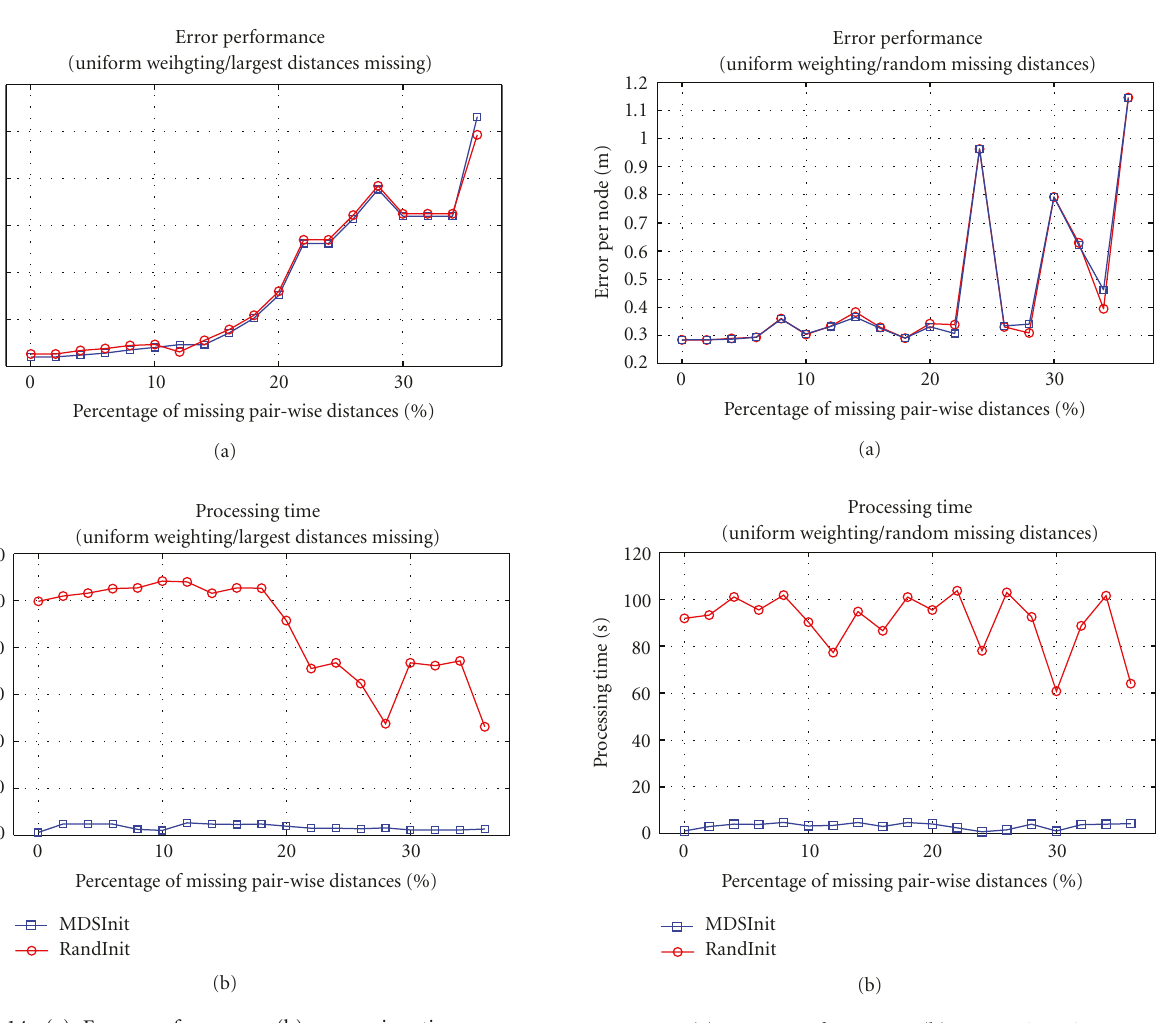
Figure 15: (a) Error performance; (b) processing time versus percentage of missing pairwise distances with uniform weighting and random missing